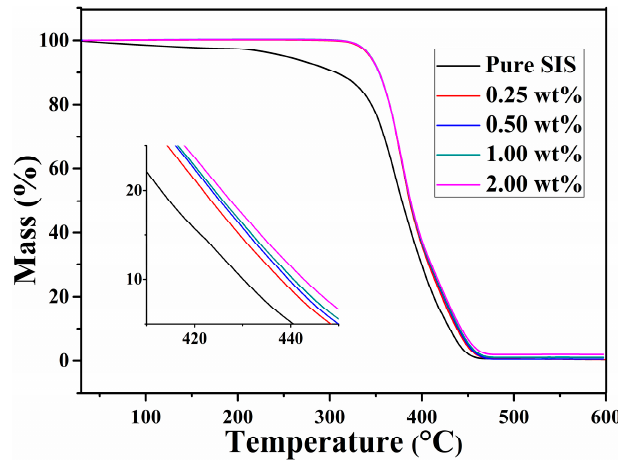
Figure 7. TG curves of SIS and graphene/SIS composites.